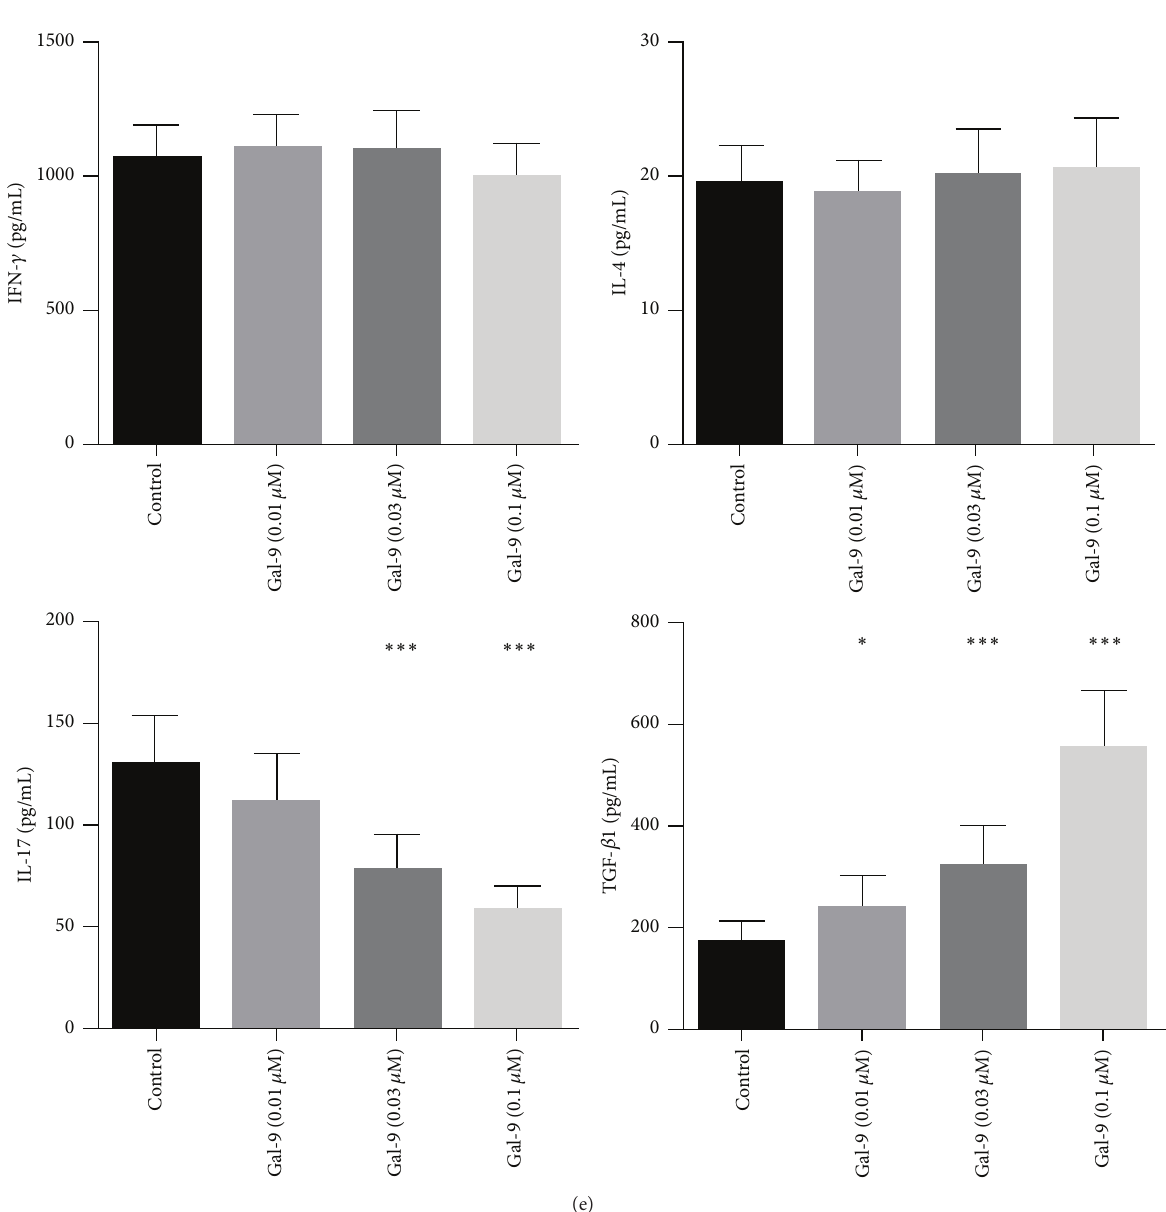
Figure 4: Recombinant Gal-9 enhances the percentage of Tregs and decreases Th17 effector response. CD3/CD28-activated PBMCs were incubated with either medium or increasing concentrations of recombinant Gal-9 for 24 h. The numbers of activated Th1 cells (CD4 + IFN- 𝛾 + ; (a)), Th2 cells (CD4 + IL-4 + ; (b)), Th17 cells (CD4 + IL-17 + ; (c)), and Tregs (CD4 + CD25 + Foxp3 + ; (d)) were determined by FACS. Gal-9 increased the development of Tregs and decreases the percentage of Th17 cells dose dependently. (e) Cytokines produced by Gal-9 exposed PBMC were measured in the supernatant by ELISA. Data represent 𝑛 = 10 independent PBMCs of NCA. ∗ 𝑝 < 0.05 , ∗∗ 𝑝 < 0.01 , and ∗∗∗ 𝑝 < 0.001 compared with